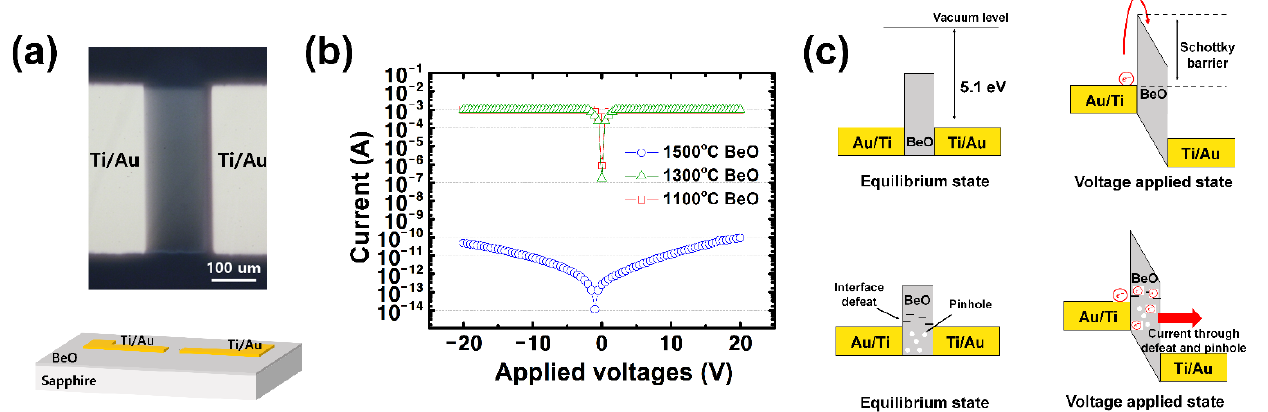
Figure 7. Insulating performance of beryllium oxide (BeO) thin films created by the two-step method: ( a ) the device structure is a metal–insulator–metal (MIM) device sandwiched in the form of Au/Ti/BeO thin film/Ti/Au. ( b ) The current–voltage bias under sweep mode is indicative of the leakage current over the applied voltage range of −2 0 V to 20 V with a compliance current of 1 mA and is plotted here on log scale on the current axis. ( c ) A schematic illustration of the leakage current passing through the MIM device, exiting through the interfacial defects and pinholes in the BeO layers.